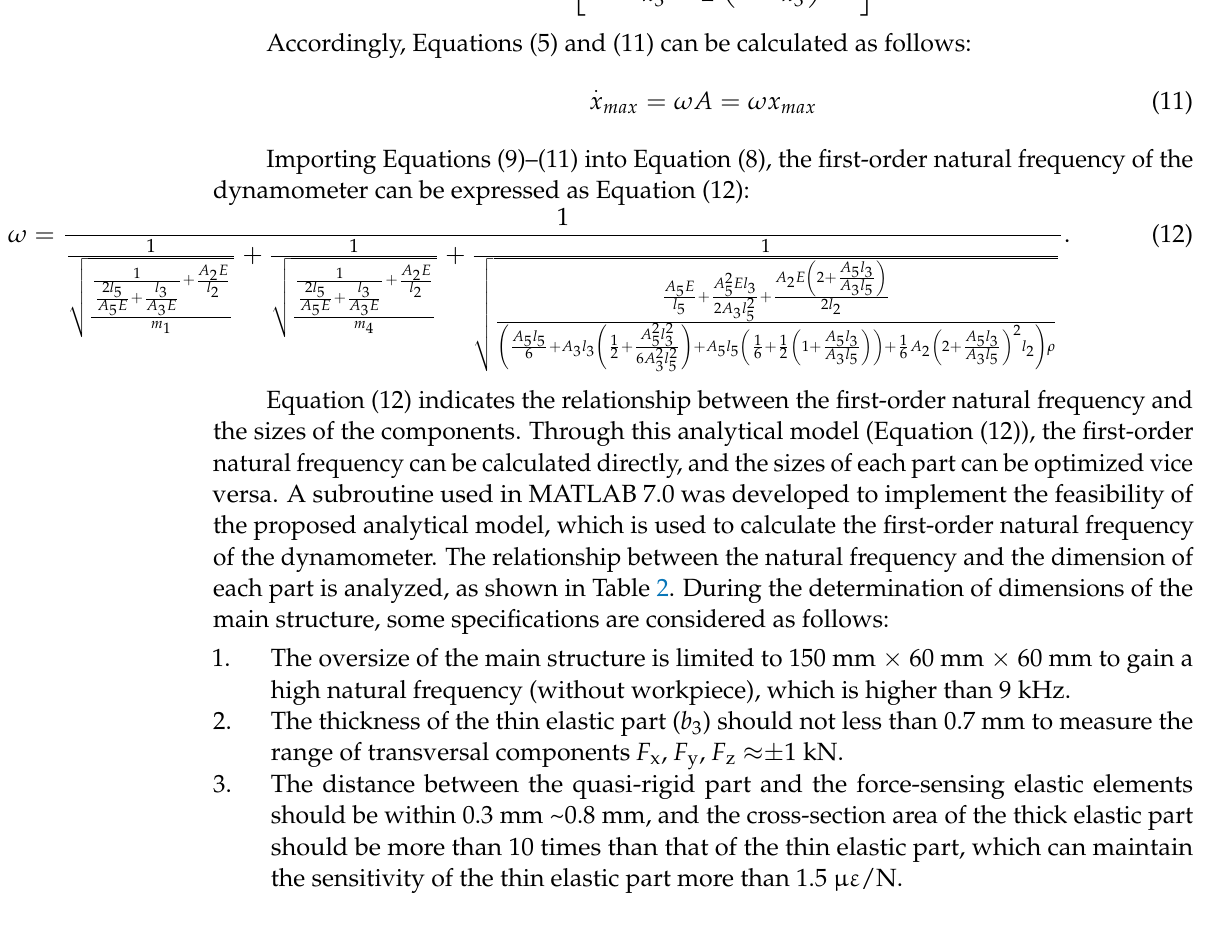
Table 2. The dimension of each part and its relationship with the natural frequency of the main structure. Dimension of Each Part of the Main Structure Dimension (mm) Relation to the Natural Frequency Length of the quasi-rigid part l 2 30 Inversely proportional Length of the thin elastic part l 3 8 Inversely proportional Length of the thick elastic part l 5 11 Inversely proportional Cross-section area of the quasi-rigid part A 2 ( a 2 × b 2 ) 30 × 30 Proportional Cross-section area of the thin elastic part A 3 ( a 3 × b 3 ) 8 × 1 Proportional Cross-section area of the thick elastic part A 5 ( a 5 × b 5 ) Inversely proportional Volume of the upper support plate V 1 ( a 1 × b 1 × l 1 ) Inversely proportional Inversely